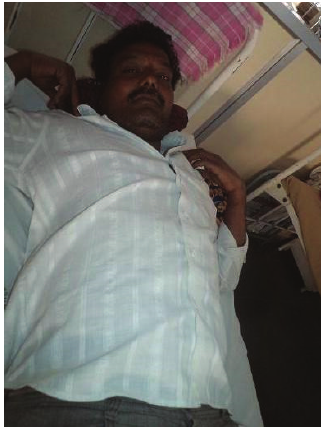
Figure 1: Patient with bilateral anterior shoulder dislocation.